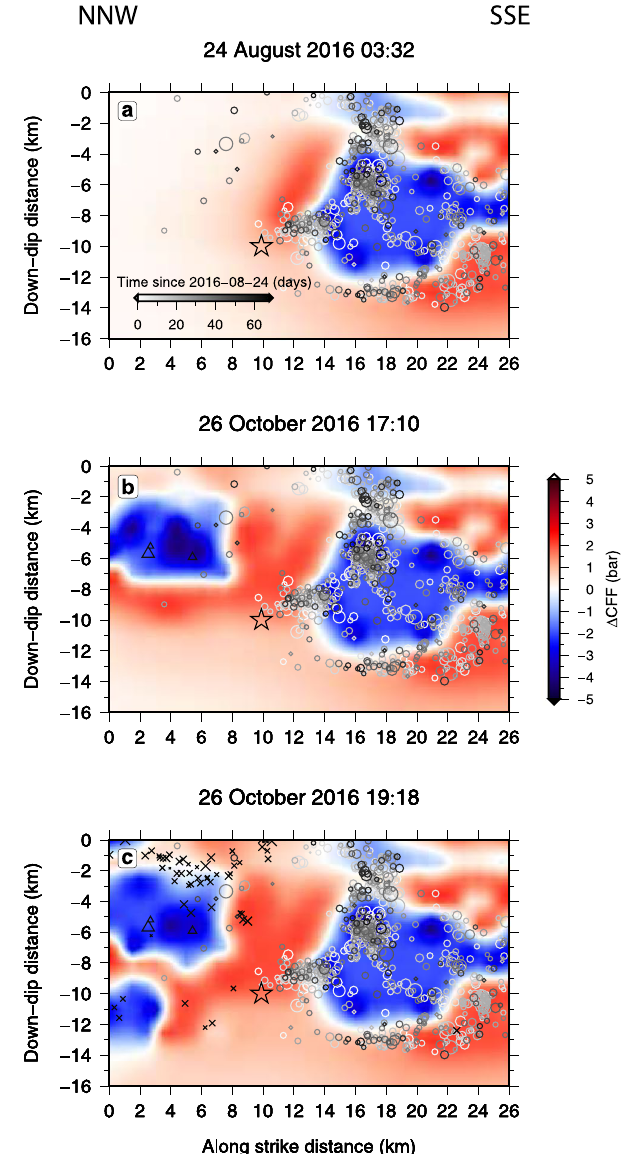
Figure 2. Coulomb failure function change ( Δ CFF ) on the fault plane of the 30 October 2016, Norcia earthquake, caused by the 3 strongest preceding events in the Amatrice seismic sequence, together with the aftershocks distribution 29 . ( a ) Δ CFF caused by the Amatrice 24 August 2016 event, along with the aftershocks (circles) occurring within 350 m (see Methods section) from the Norcia fault plane and up to 26 October 2016 17:10. Aftershocks are colour coded based on their origin time since 24 August 2016 (see time line in Fig. 2a). Positive and negative variations indicate respectively increased and decreased Δ CFF areas. ( b ) Same as ( a ), with the addition of the Δ CFF contribution of the 26 October 2016 17:10 and aftershocks (triangles) up to 26 October 19:18 UTC. The evident invariance of the Δ CFF in the southern half of the fault plane in the ~60 days time period indicates the negligible effect of viscous relaxation in the lower crust. ( c ) Same as ( b ), with the addition of the Δ CFF contribution of the 26 October 2016 19:18 UTC and aftershocks (crosses) up to 30 October 2016. In all the panels, the black empty star corresponds to the location of the Norcia event hypocenter 29 (rupture